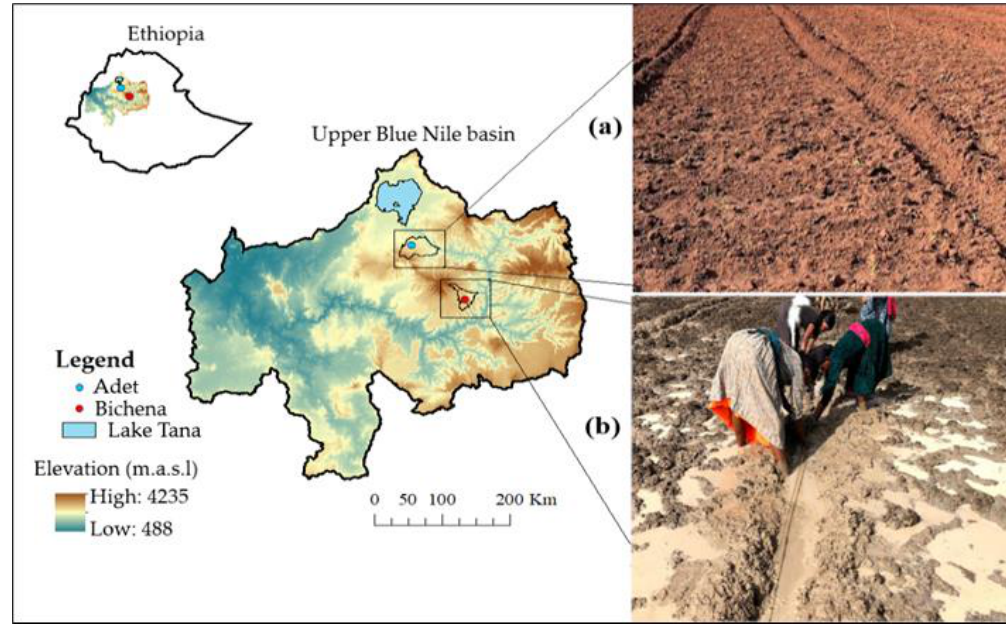
Figure 1. Map of the study areas and pictures ( a ) and ( b ) showing the field conditions and land preparation at the two locations, Adet and Bichena, during teff planting time.